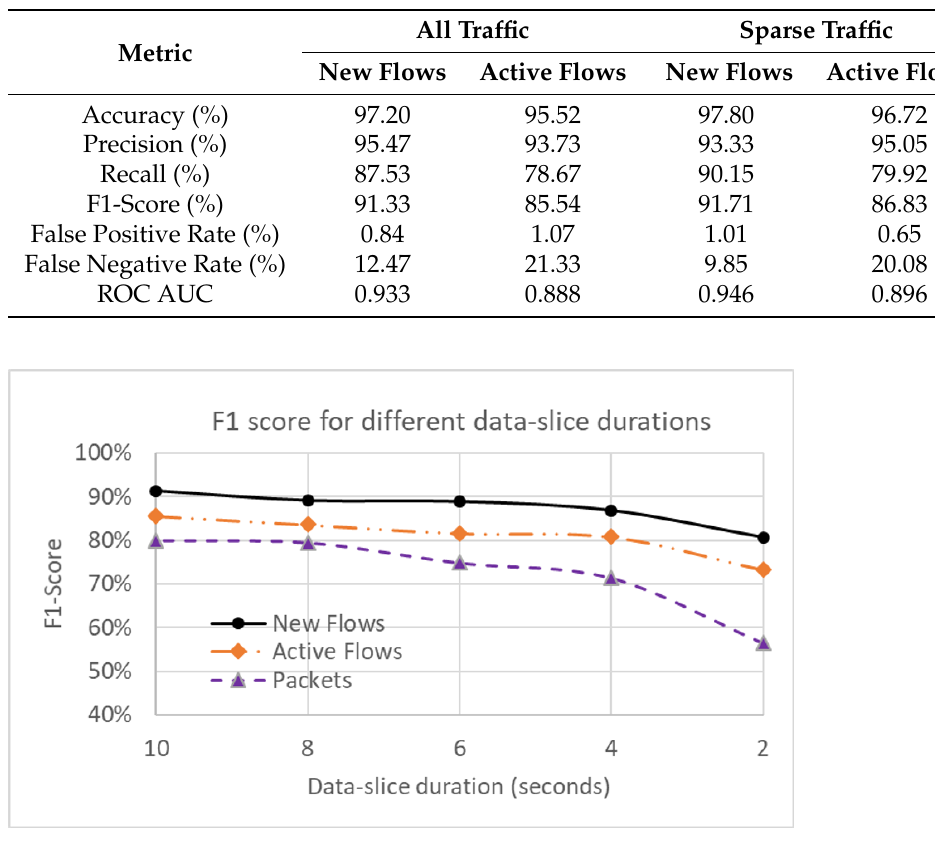
Figure 10. F1-scores of PCA-SVM for different data-slice